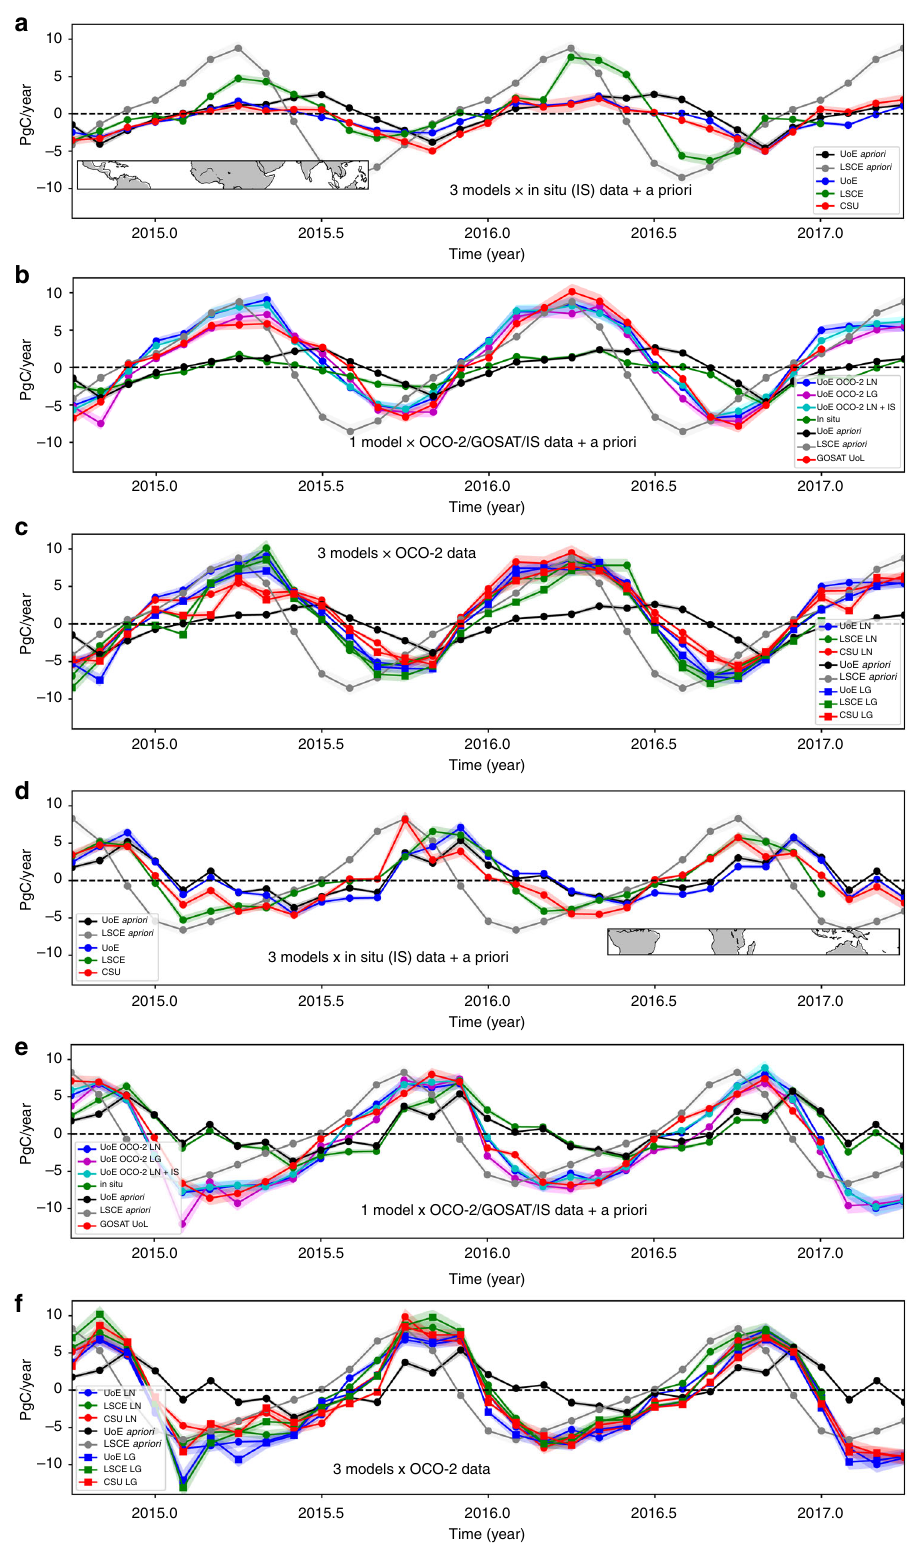
Fig. 1 Northern and southern tropical CO 2 fl uxes. Monthly a priori and a posteriori CO 2 fl uxes (expressed as PgC year − 1 , mid-2014 to 2017) from the ( a – c ) Northern and ( d – f ) Southern tropics inferred from ( a , d ) in situ mole fraction measurements and from ( b – c , e – f ) GOSAT and OCO-2 satellite measurements of X CO2 . Positive fl uxes are from the land surface to the atmosphere. LN and LG denote X CO2 measurements taken using nadir and glint observing modes, respectively. The geographical regions are shown inset of each upper